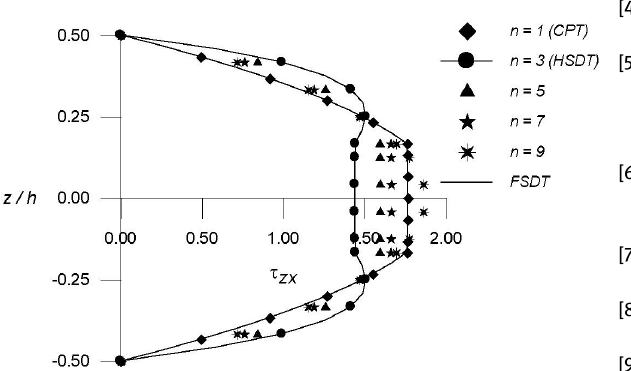
Figure 13: Through thickness distribution of transverse shear stress ( ¯ τ zx ) for simply supported three layered (0 ∘ /90 ∘ /0 ∘ ) symmetrically laminated composite plates with a / h = 4 and E 1 / E 2 = 25